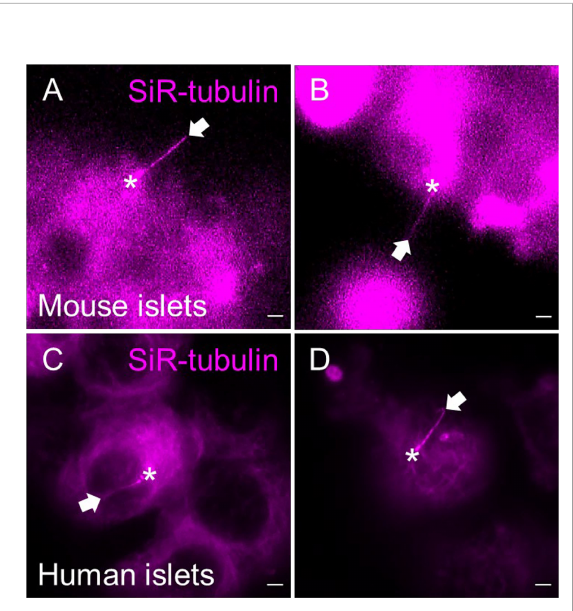
FIGURE 7 SiR-tubulin labeling of islet cilia for live-cell imaging. The far-red microtubule probe SiR-tubulin (magenta) labels primary cilia in partially dissociated and reaggregated mouse (A, B) and human (C, D) islets. Still images represent maximal intensity projections of confocal z-stacks. White arrows, cilia. Asterisks, centrioles. Scale bars, 2